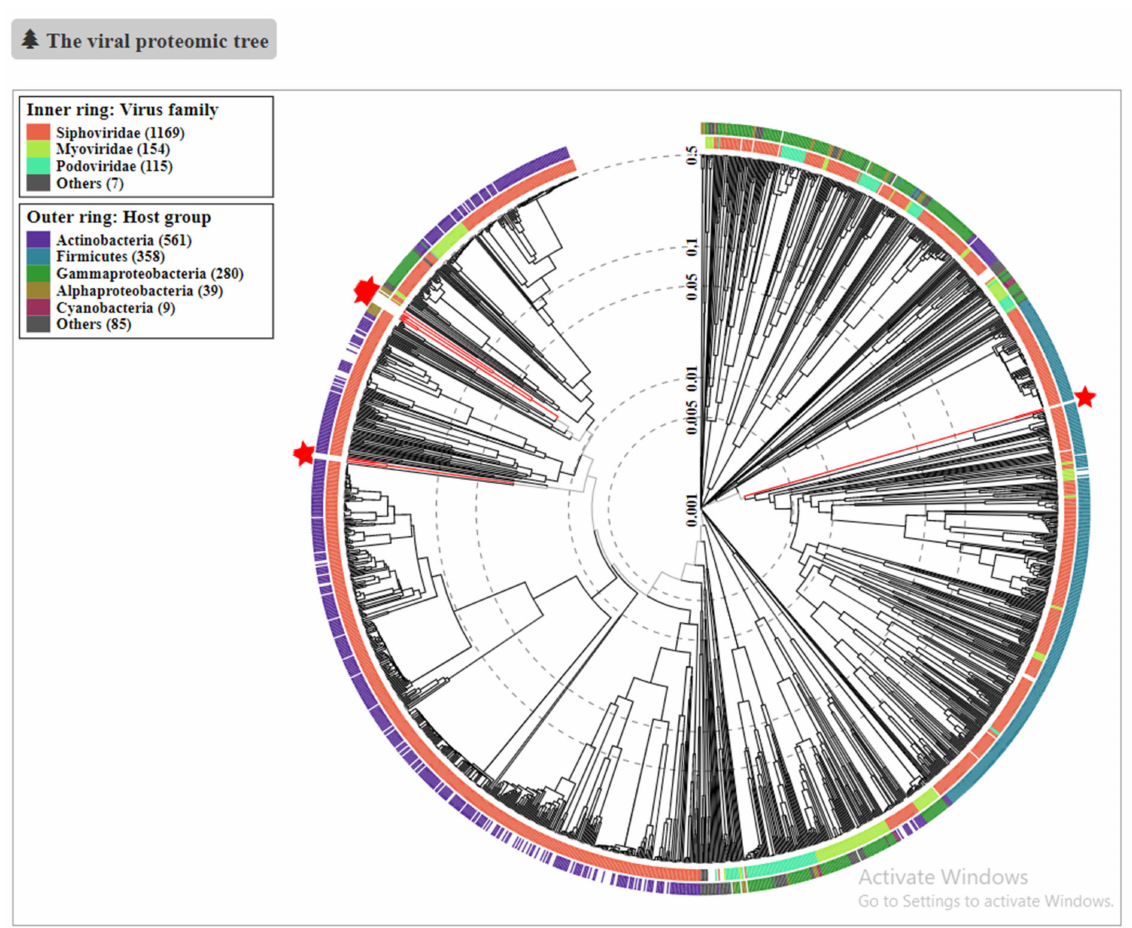
Figure 6. ViPtree circular proteomic tree of related dsDNA viruses with prokaryotic hosts. Submitted prophage sequences are highlighted with red